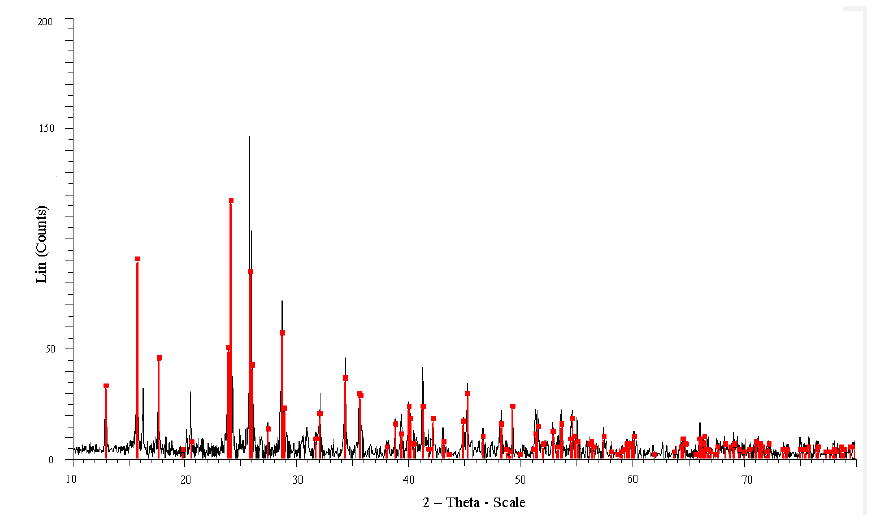
Fig. 5 X-ray diffraction pattern of sample Al 0 . 3 La 0 . 7 P 3 O 9 .